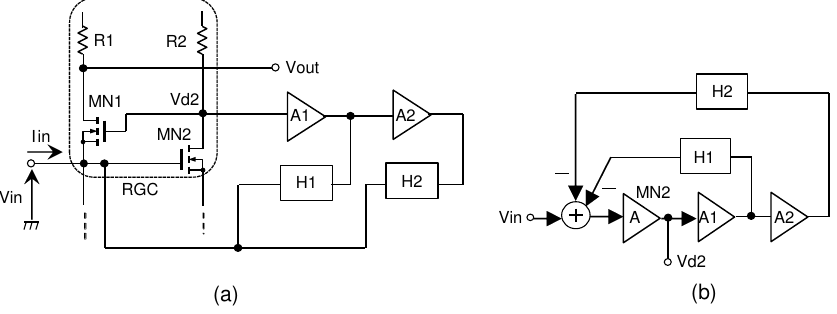
Figure 4. Conventional TIA block diagram. ( a ) A part of RGC and multi-feedback stage. ( b ) Block diagram for transfer function analysis.